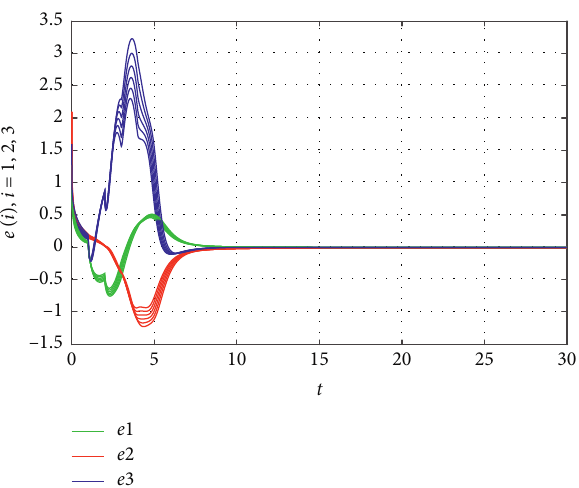
Figure 1: The change processes of error e